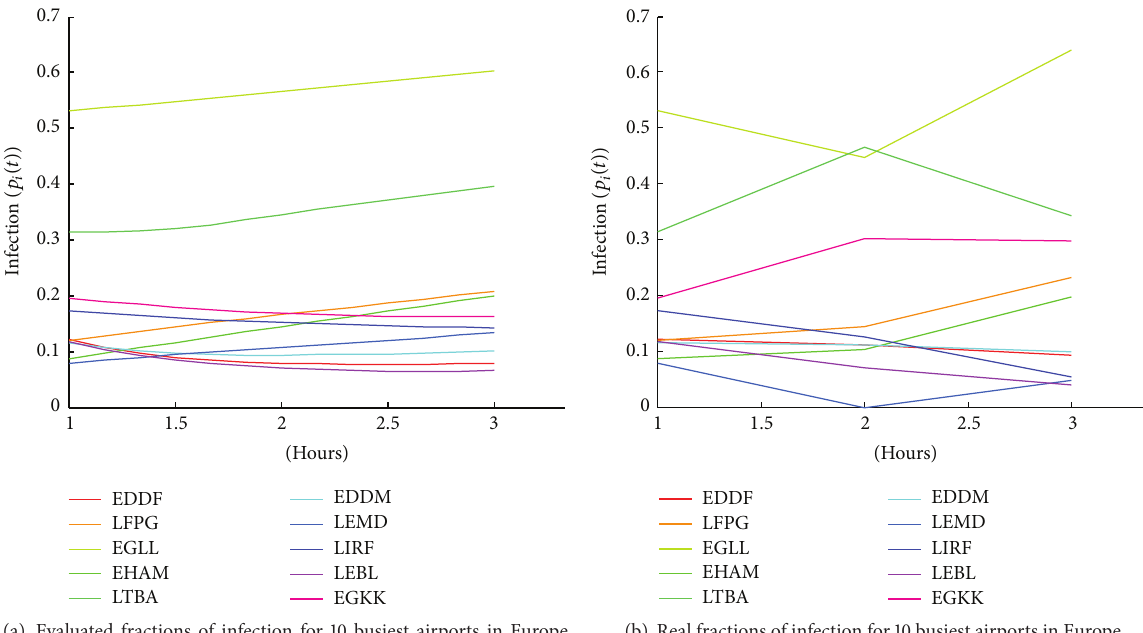
Figure 10: Comparison between the results of the airport-based metapopulation model and real data on August 25,